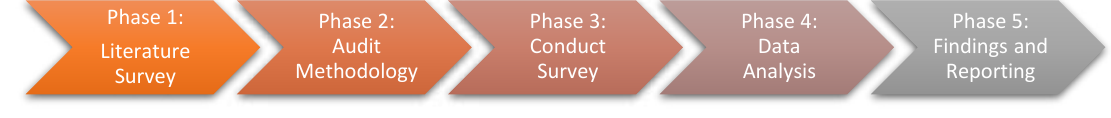
Figure 1. Research